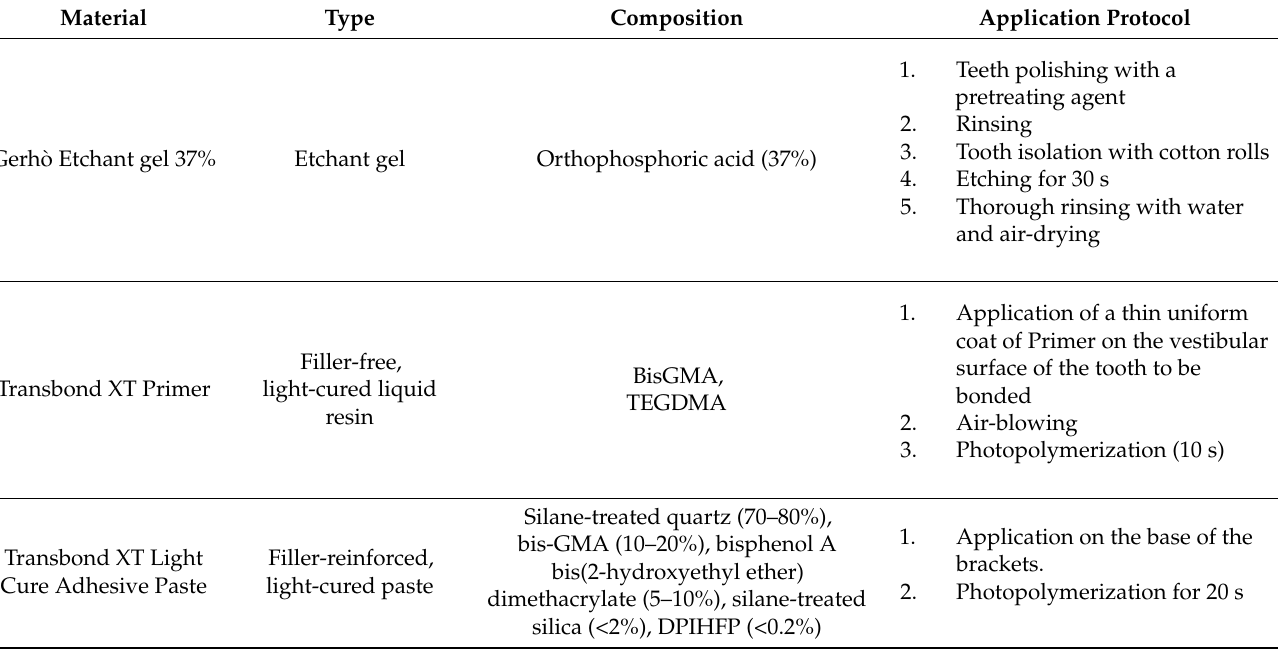
Table 2. Characteristics of the materials used, and application protocols recommended by the